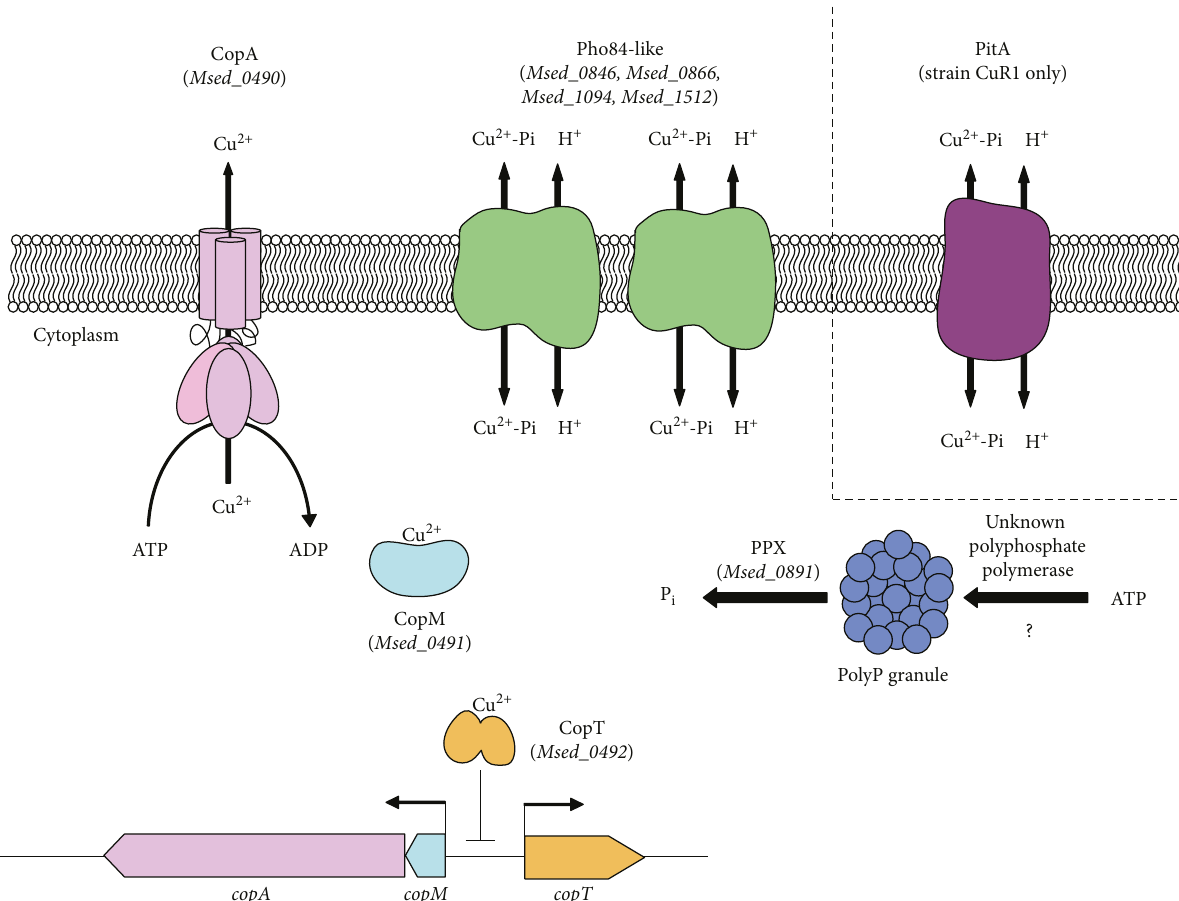
Figure 7: Cartoon working model for copper resistance in M. sedula . In M. sedula DSM 5348 T , copper ions could bind to the transcriptional repressor CopT ( Msed_0492 ) and prevent the binding of this protein to the DNA to activate the transcription of copA ( Msed_0490 ), copT , and copM ( Msed_0491 ) genes. CopM is a possible Cu-binding protein that could sequester copper ions in the cytoplasm. CopA is a putative P-type metal-e ffl ux ATPase that could couple the e ffl ux of copper ions from the cytoplasm and the energy from ATP hydrolysis. On the other hand, PPX ( Msed_0891 ) could hydrolyze PolyP to generate P that could complex copper ions. These complexes could be transported outside the i cell, together with H + by the H + -phosphate symporters, such as the Pho84 -like phosphate transporters ( Msed_0846 , Msed_0866 , Msed_1094 , and Msed_1512 ) in both strains DSM 5348 T and CuR1. This last strain has an additional PitA phosphate transporter that could enhance the e ffl ux of complexes and would explain its higher copper resistance. This model is based on the results of the present work and previously reported proposals [8, 9, 11, 13, 19, 29, 34,